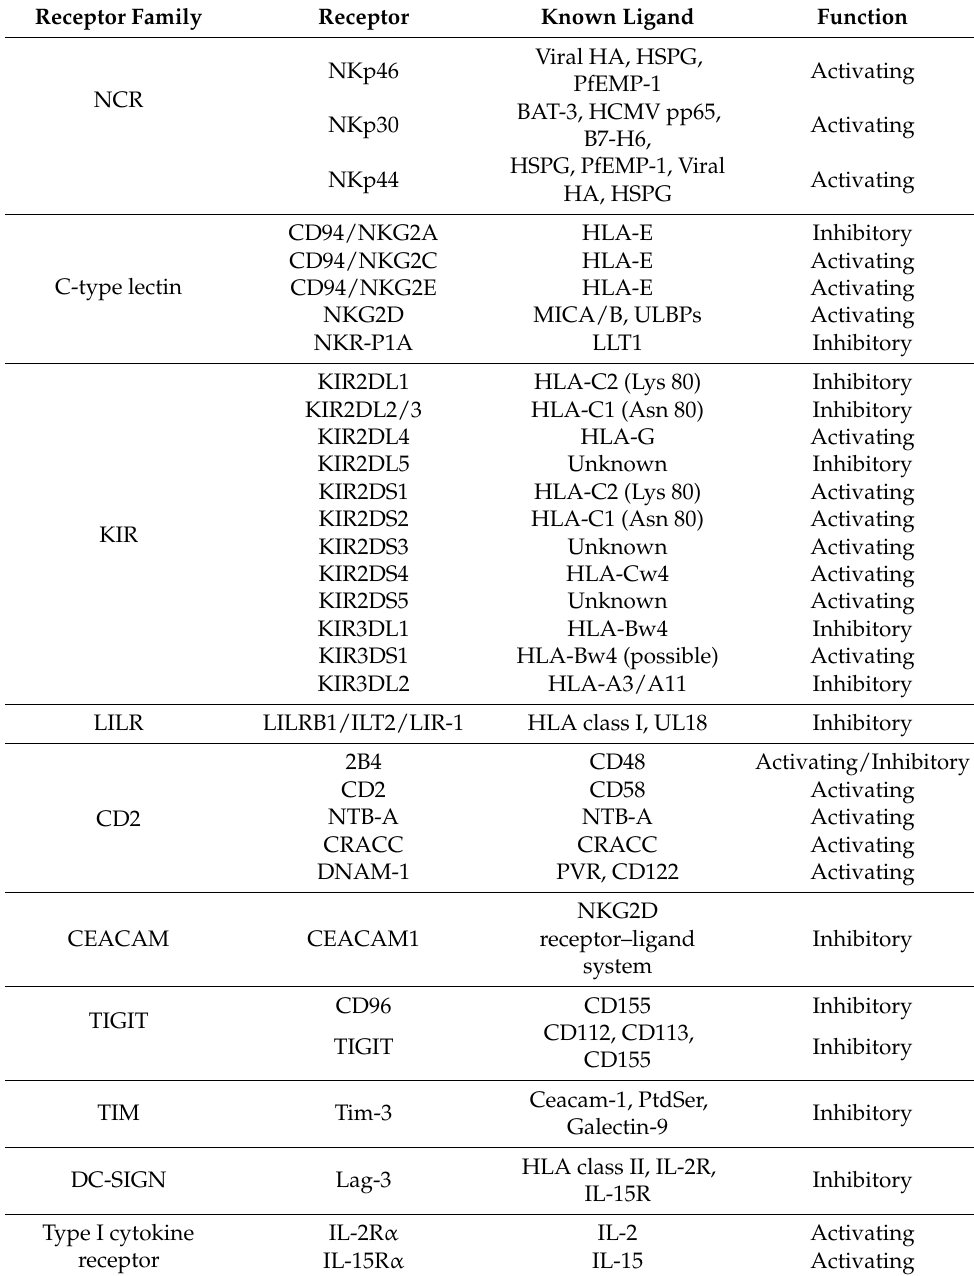
Table 1. Principal NK cell receptors (activating and inhibitory) and